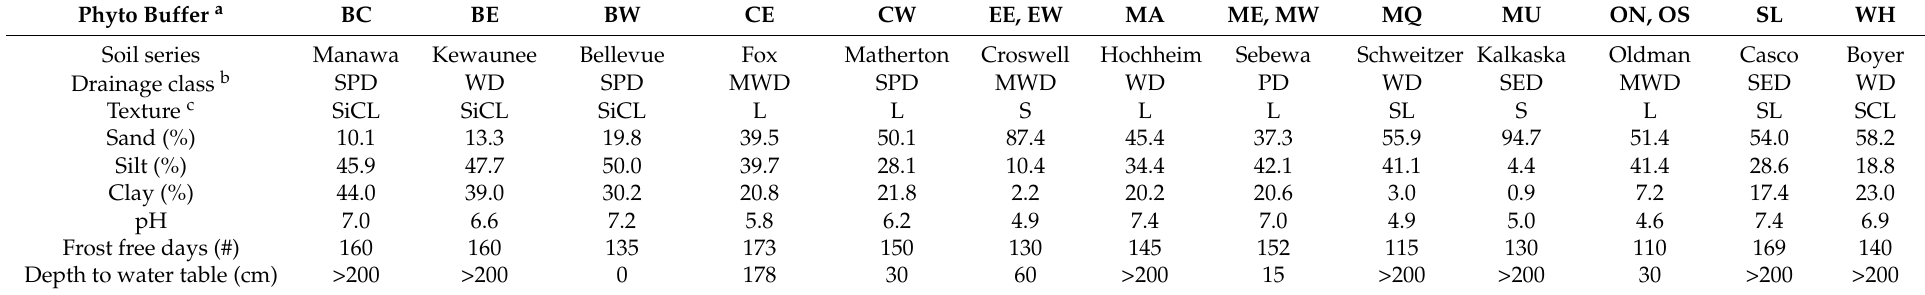
Frost free days (#) Depth to water table (cm) >200